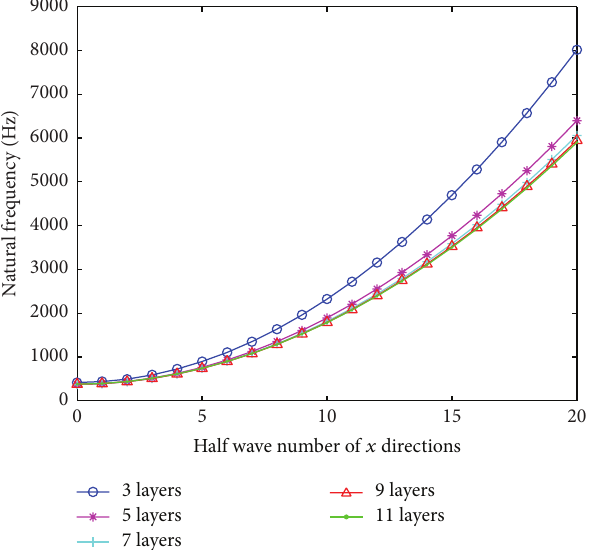
Figure 9: The natural frequency of constrained damping plate with various layers ( 𝑛 = 10 ).